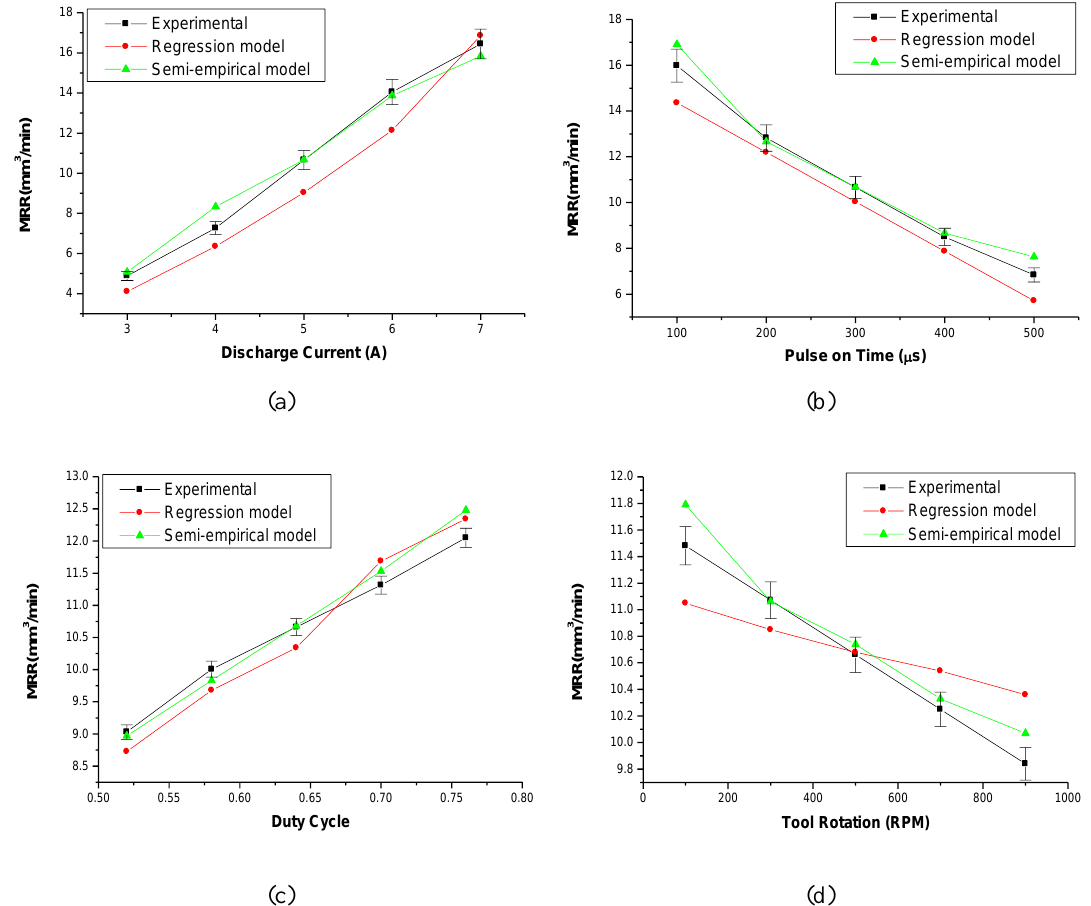
Figure 2. The comparative study of MRR between the experimental, regression and semi-empirical models